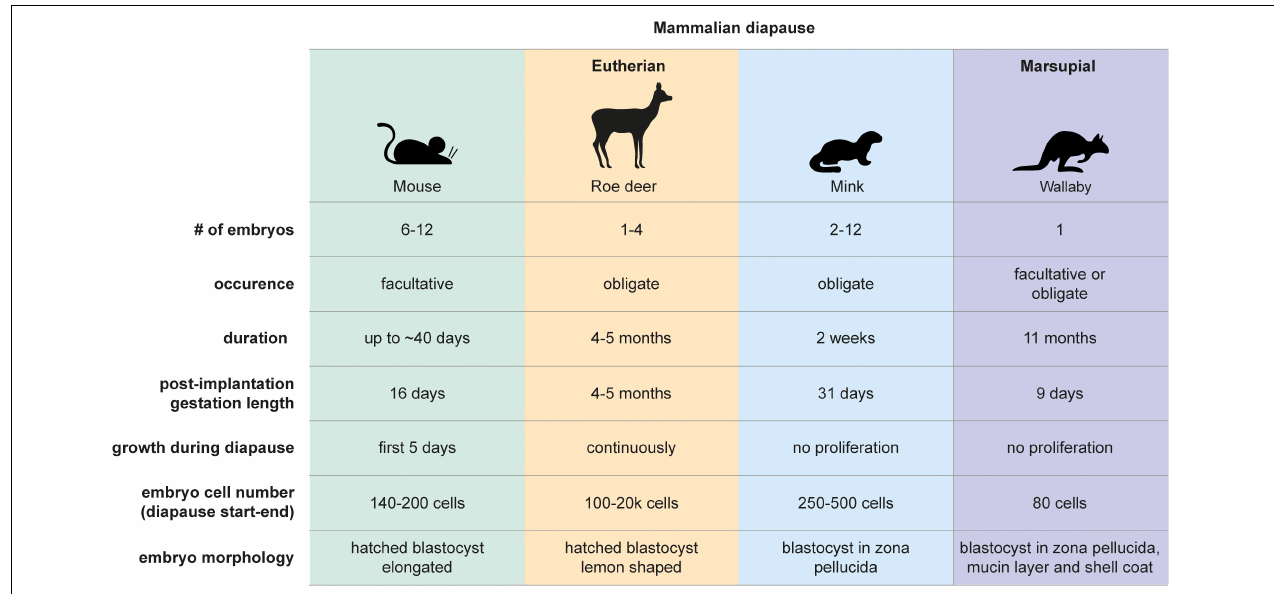
FIGURE 1 | Mammalian diapause characteristics in the mouse, roe deer, mink, and wallaby. Embryo morphology, diapause duration, and embryo number differ between species. Diapause duration is independent of the length of post-implantation gestation. Diapause is triggered either seasonally (obligate) or due to lactational stress (facultative). Embryo reactivation is triggered by alterations in photoperiod (mink, wallaby, roe deer) or end of lactation (mouse,